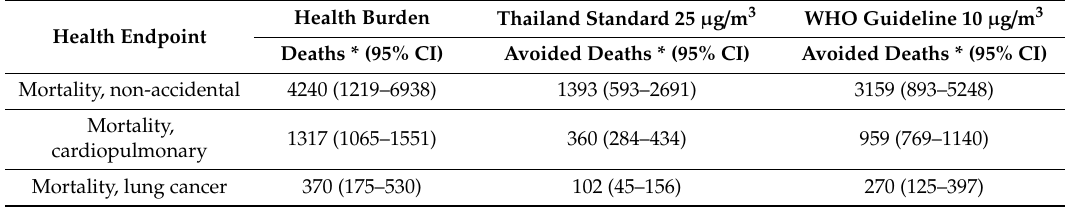
Table 5. Health burden and avoided deaths in 2016 due to rollbacks to the Thai National Ambient Air Quality Standards (NAAQS) and the World Health Organization (WHO)